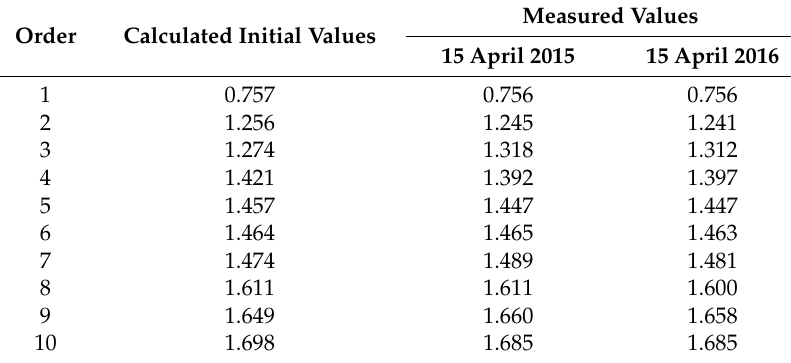
Table 3. Calculated and measured girder vibration frequency